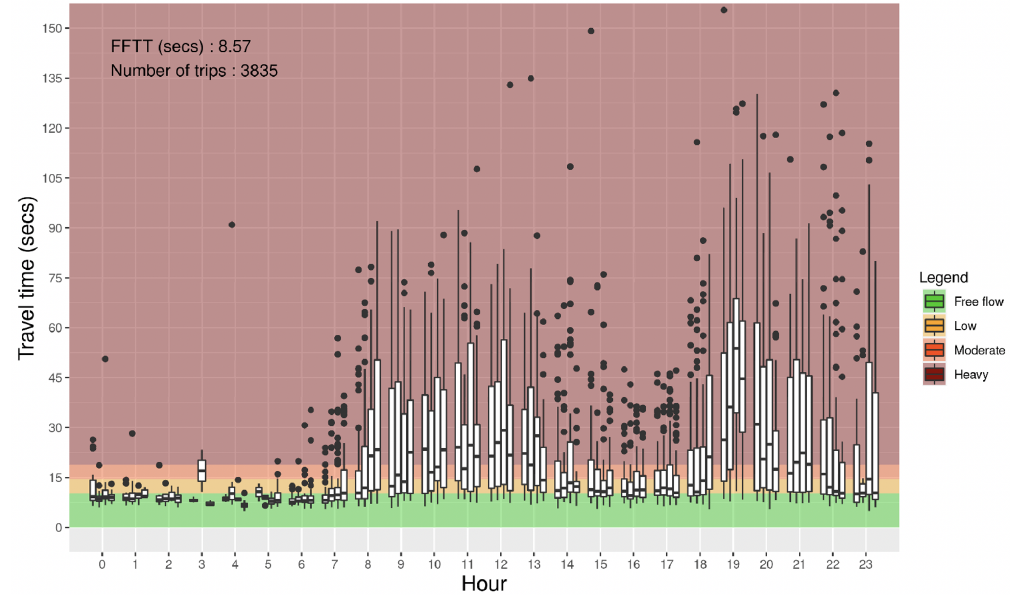
Figure 9. Travel time boxplots as a function of time of the day with TTI classes observed on osm_id 32803592 (fraction start-end: 0.16–1.00) (Bathurst Street south, Toronto).